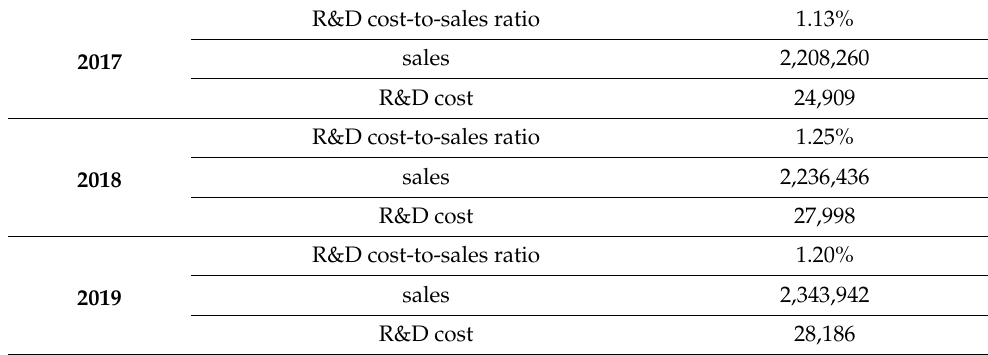
Table 3. The present condition of Nongshim’s R&D investment (in millions of Korean won (KRW)). R&D cost-to-sales ratio 2017